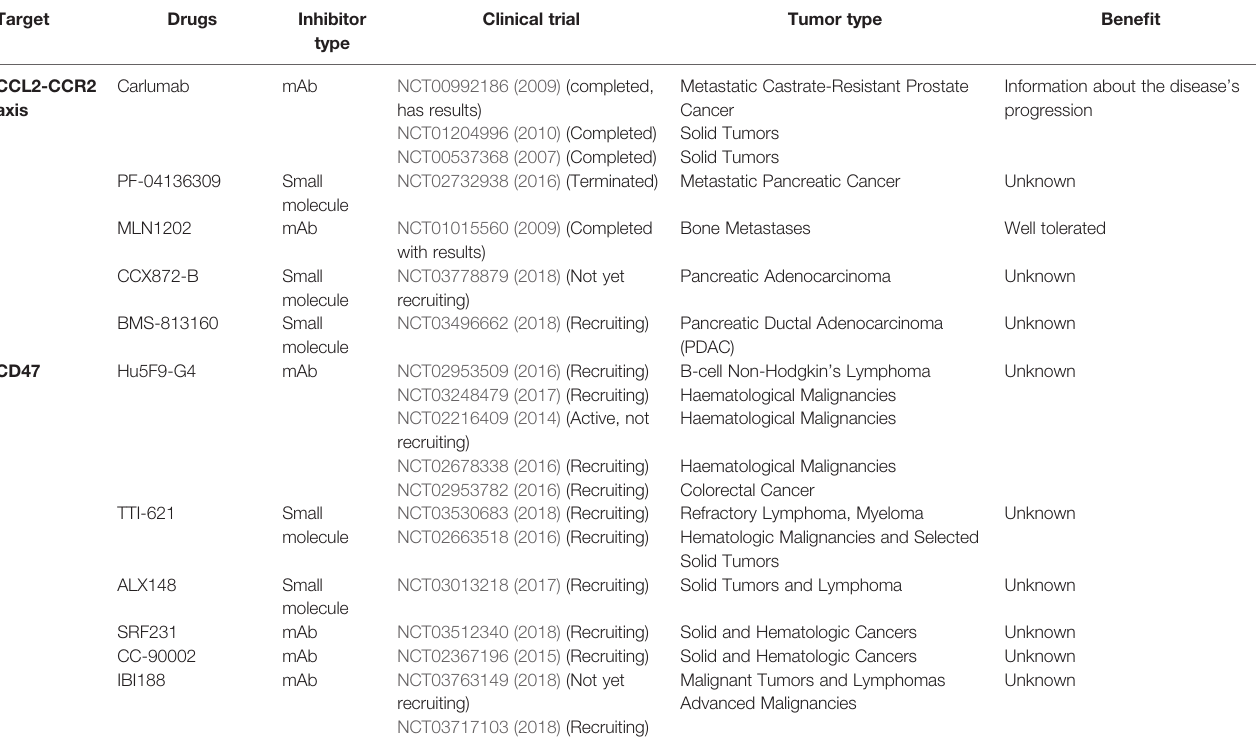
TABLE 1 | Clinical trials targeting the recruitment of